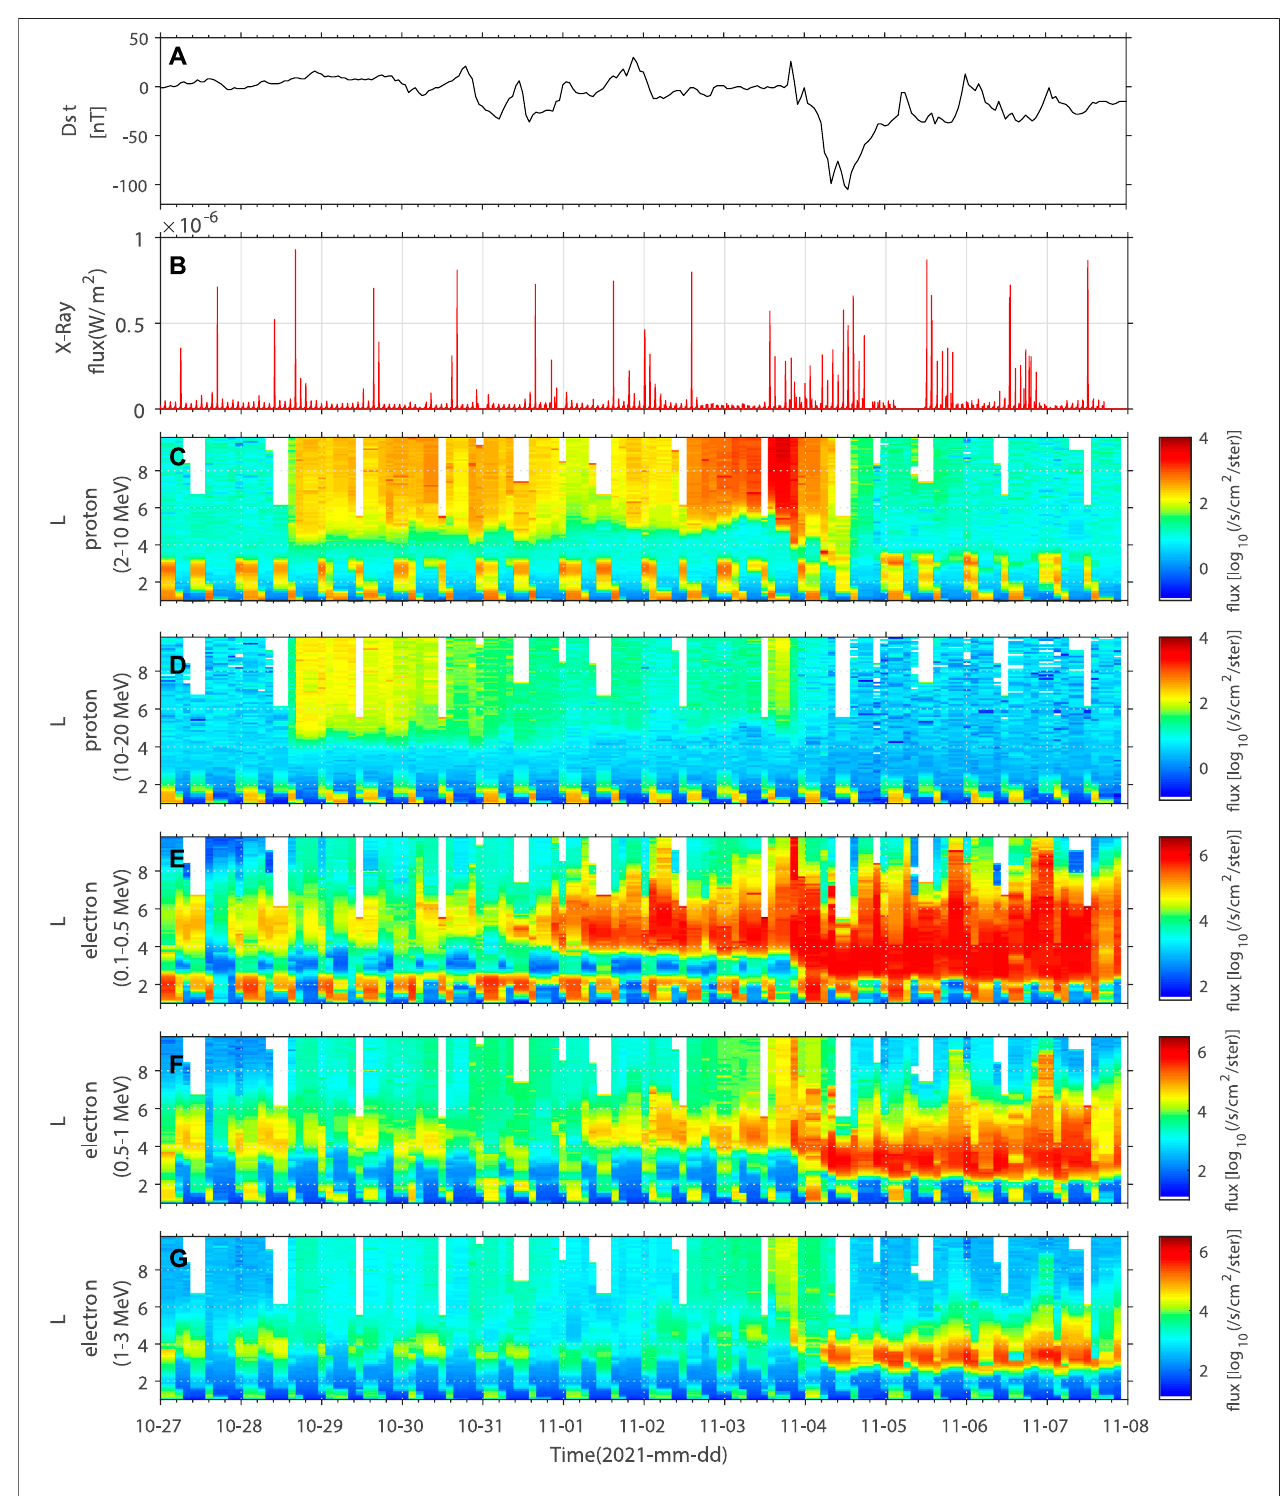
FIGURE 9 | The evolution of the Dst index, X-rays, protons, and electrons during the SPE and induced geomagnetic storm from 27 October 2021 to 8 November 2021. (A) Evolution of the Dst index. (B) X-ray fl uxes observed by HEPP-X. (C) and (D) are the proton fl uxes observed by ZH-1 with energies of 2 – 10 MeV and 10 – 20 MeV. (E) , (F) , and (G) are the electron fl ux distribution at 0.1 – 0.5 MeV, 0.5 – 1 MeV, and 1 – 3 MeV energies, respectively.